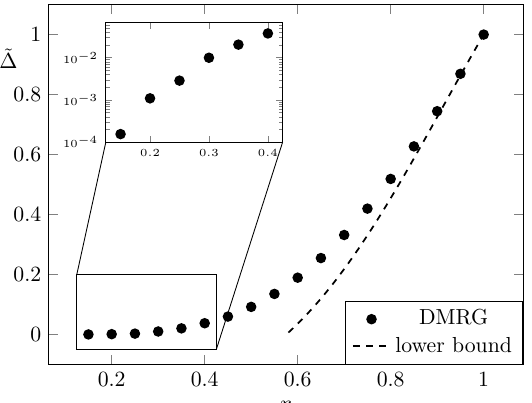
Figure 2: Energy gap ˜ ∆ above the six-fold degenerate ground states of the frustration- free ANNNP model (122). The dots show the energy gap obtained by extrapolating the finite-size data for L = 64,76,88,100 to the thermodynamic limit. The dashed line is the lower bound for the energy gap obtained in Appendix